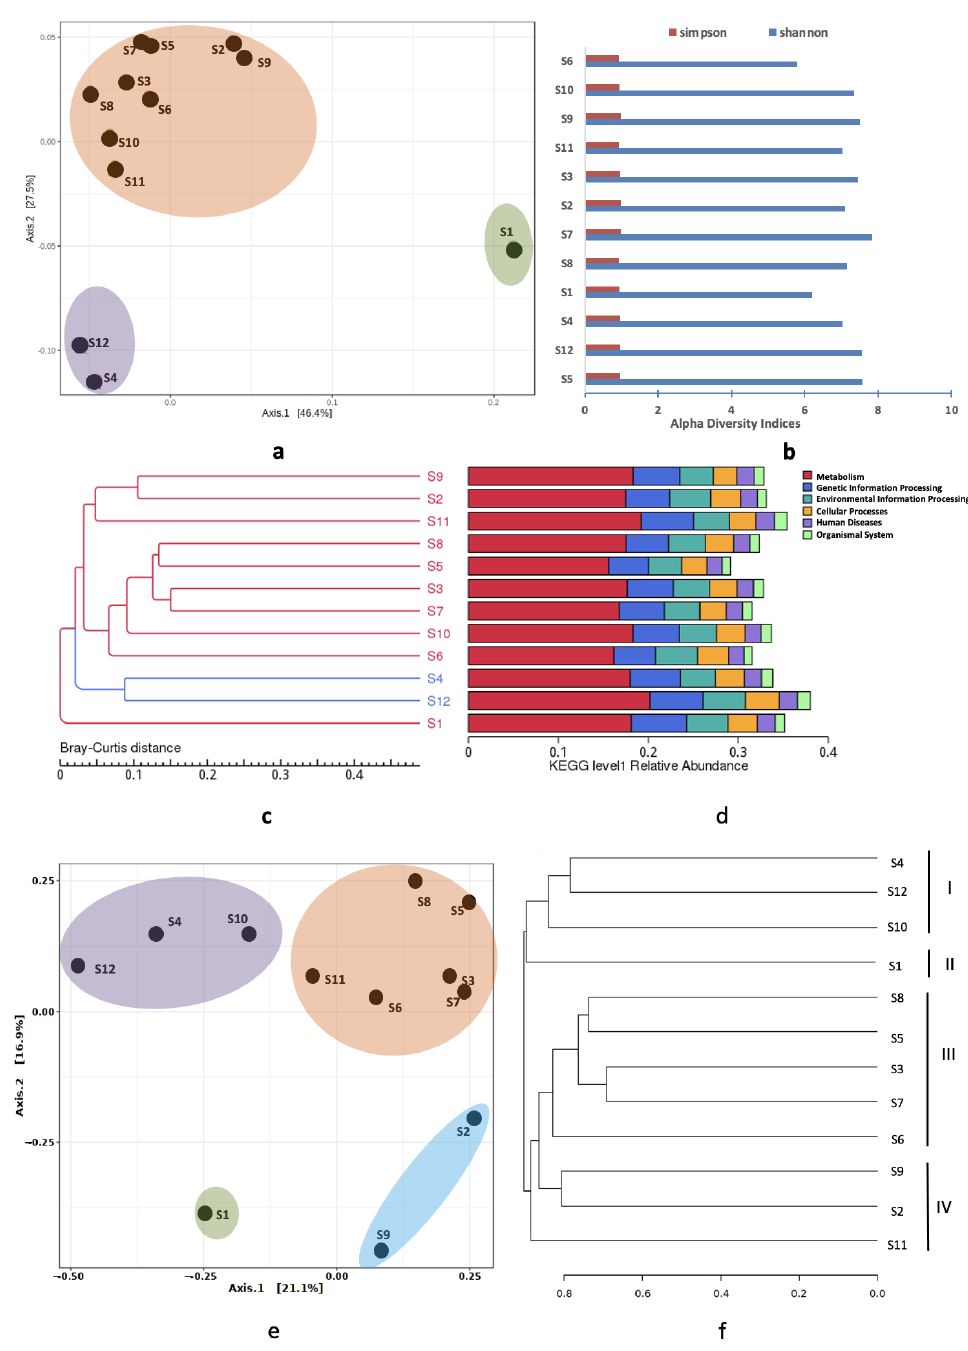
Figure 8. Spatial variations at taxonomic and functional levels. ( a ) Ordination analysis on RA of microbial taxa. The colors represent the three clusters ( b ) Alpha diversity indices of Shannon and Simpson. ( c ) Dendrogram and ( d ) Cluster of KEGG level 1 RA. Stations S4 and S12 are shown as blue lines. ( e ) Ordination analysis based on RA of ARGs. The four clusters are shown in different colors ( f ) Dendrogram based on RA of ARGs filtered from the marine sediments of